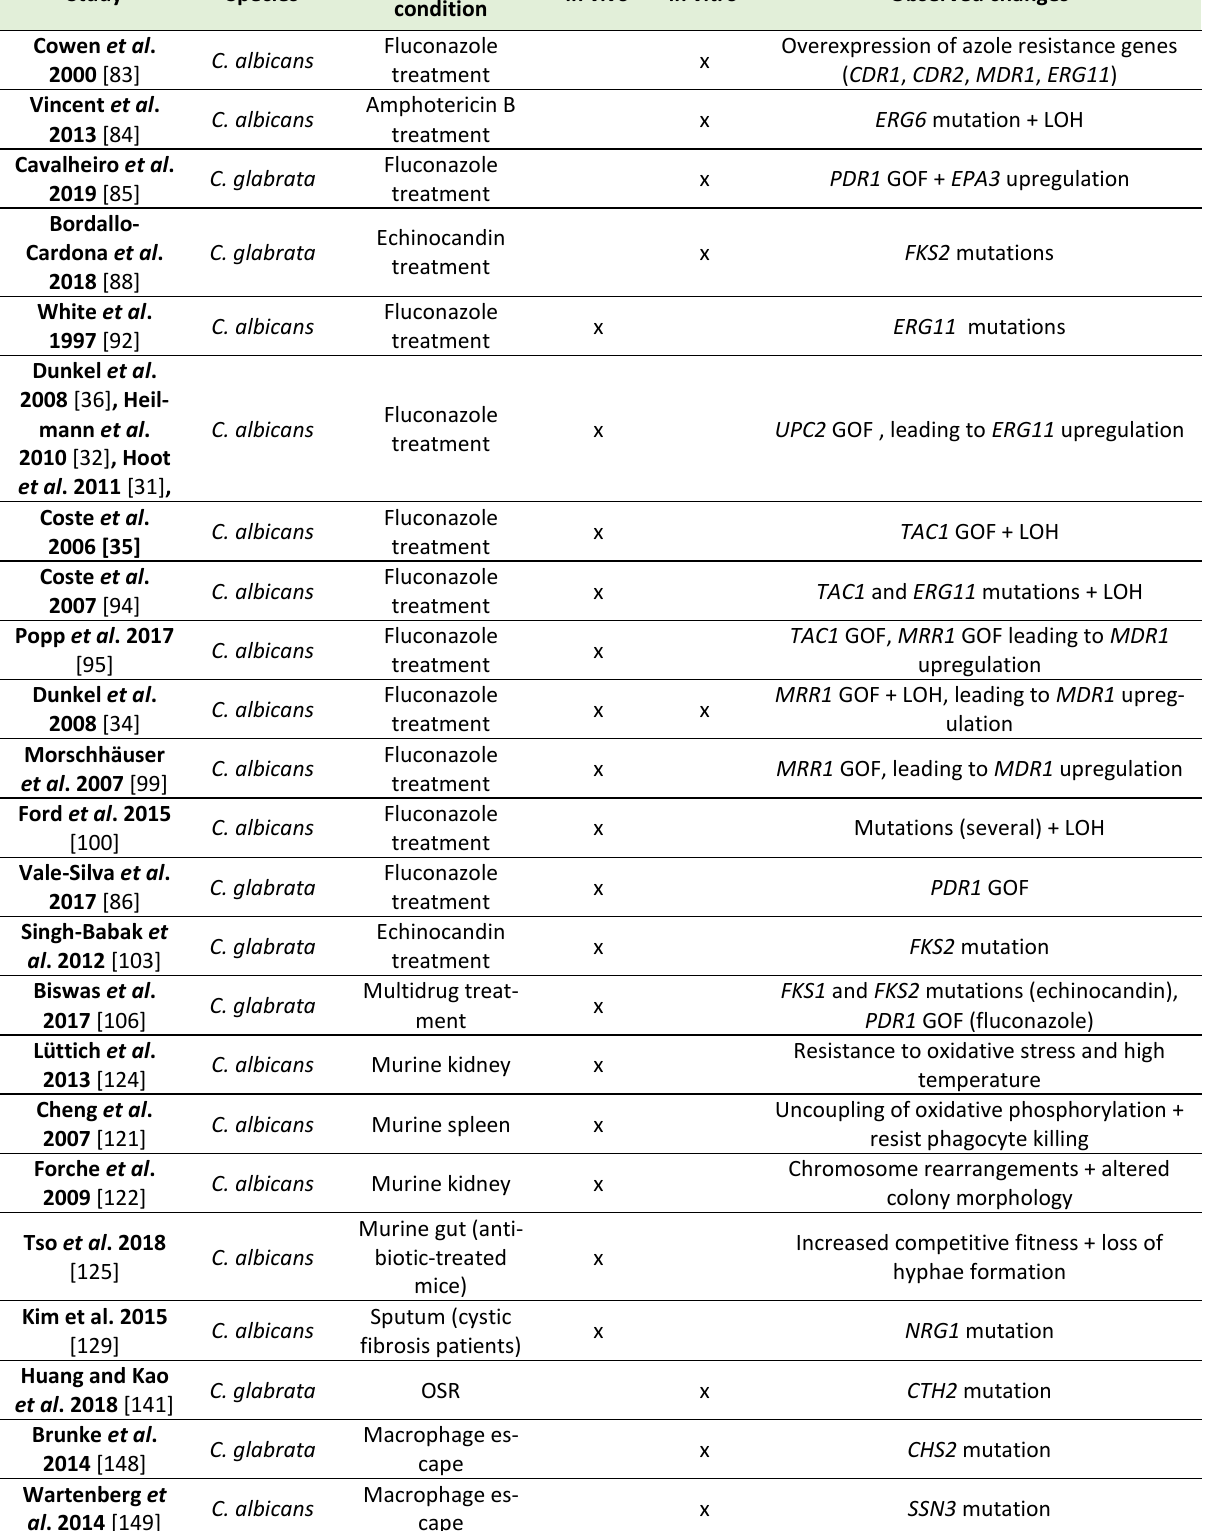
TABLE 1. Reported mechanisms of adaption to antifungal treatment, host niches and immune attack in C. albicans and C. glabrata as determined by microevolution studies. Both in vivo or in vitro studies are considered. The main features found to be associated with evolution events in each condition are